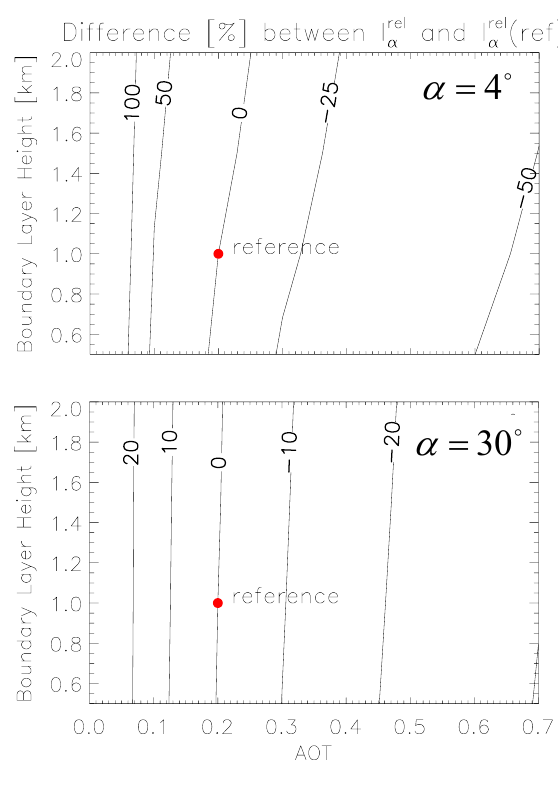
Fig. 9. Difference between the modeled relative intensity for a range of AOT and BLH values, and the reference value of relative intensity for AOT=0.2 and a boundary layer height of 1 km (red dot). Two elevations were used in the calculations: 4 ◦ (top) and 30 ◦ (bottom). Solar zenith angle = 50 ◦ , relative azimuth angle = 180 ◦ , λ =428 nm .